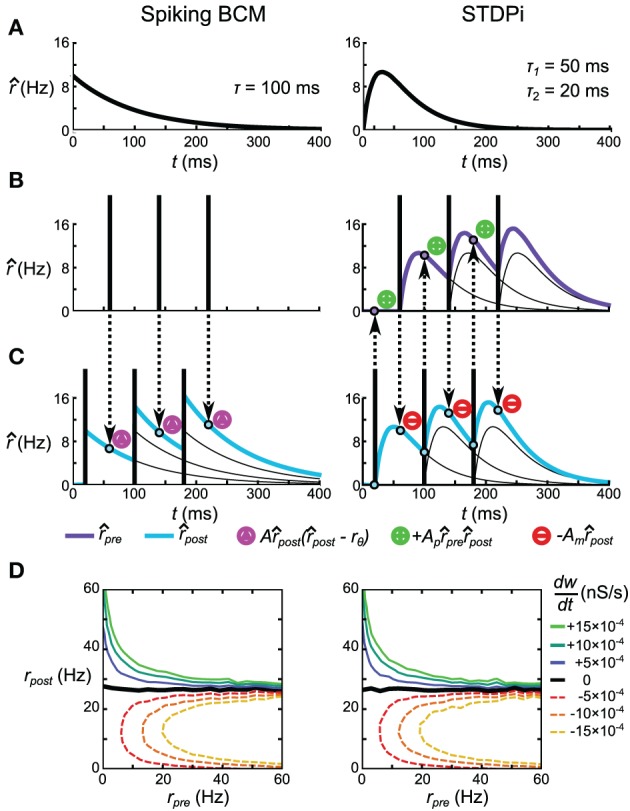
Spike-based plasticity rules that implement the rate-based BCM rule. (A) Kernels used to estimate the pre-synaptic (STDPi only) and post-synaptic (both rules) rates. The kernel for Spiking BCM is an exponential kick-and-decay with a single time constant, while the kernel for STDPi is a difference of two exponentials. Both kernels equal zero for t < 0. (B,C) Schematic diagram of the operation of the two rules given a pre-synaptic spike train (B) and a post-synaptic spike train (C). Circumscribed magenta triangles signify when the Spiking BCM adjusts the synaptic weight (both in positive and negative directions). Circumscribed green pluses and red minuses signify when STDPi respectively potentiates and depresses the synaptic weight. (D)
dwdt as a function of uncorrelated, Poisson distributed pre- and post-synaptic rates.